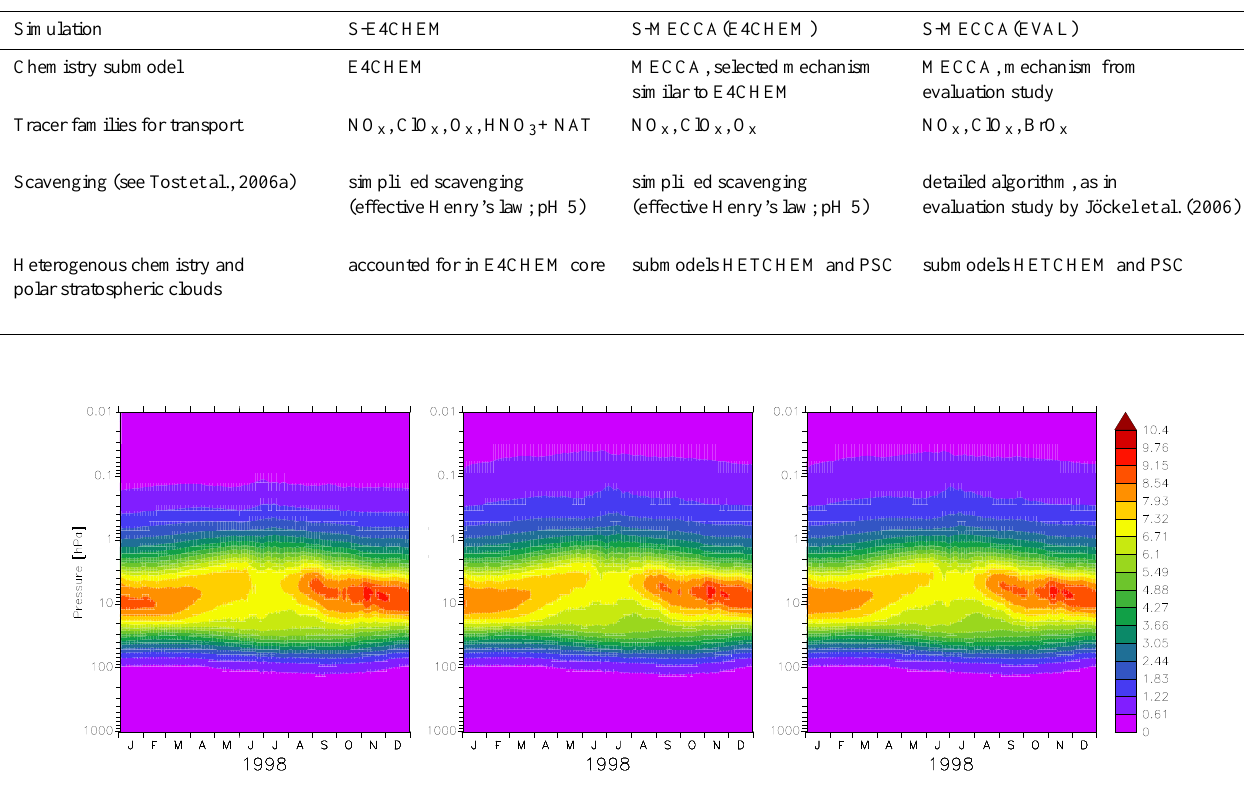
Fig. 2. EMAC ozone (µmol/mol) from simulations with S-E4CHEM (left), S-MECCA(E4CHEM) (middle) and S-MECCA(EVAL) (right) for the zonal average at 30 ◦ S–50 ◦